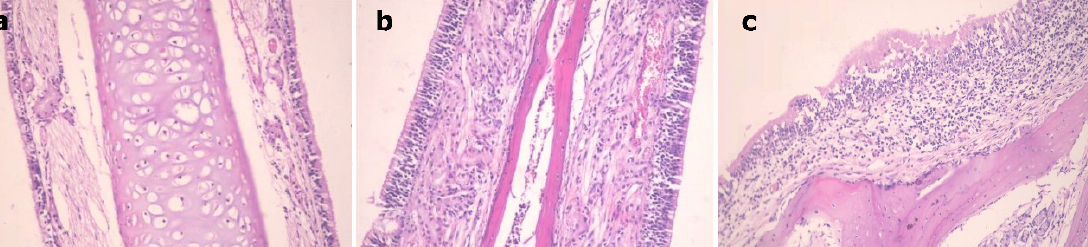
Figure 6. Nasal mucosal tissue of: ( a ): control mouse, ( b ): mouse received EH solution, ( c ): mouse received EH mucoadhesive